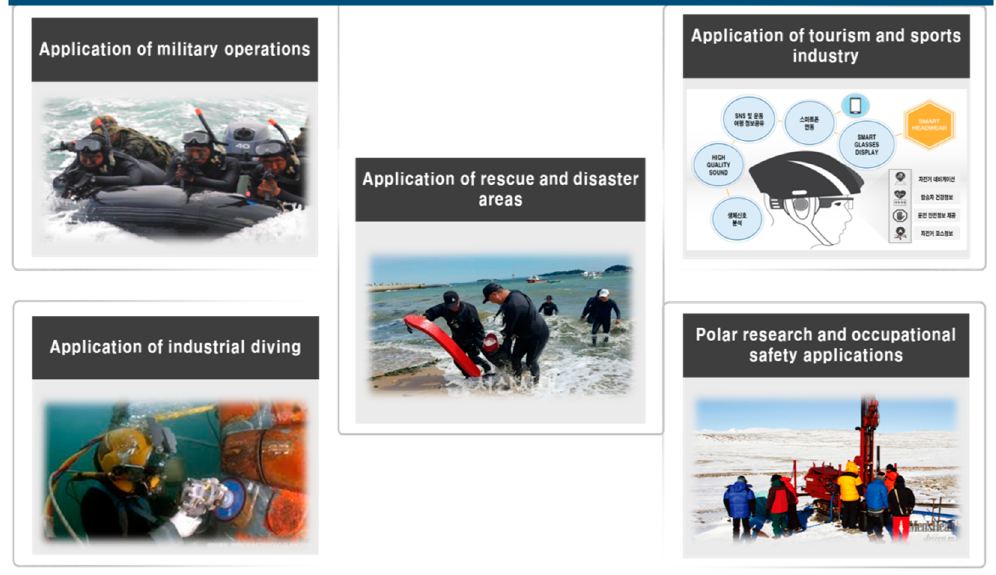
Figure 15. Application areas of DiverPAD.